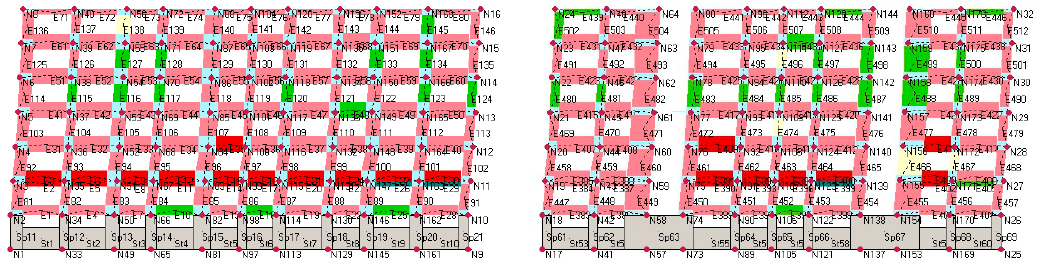
Figure 18. Wall damage after exposure to PGA = 0.2 g—inadequate behavior of the structure.